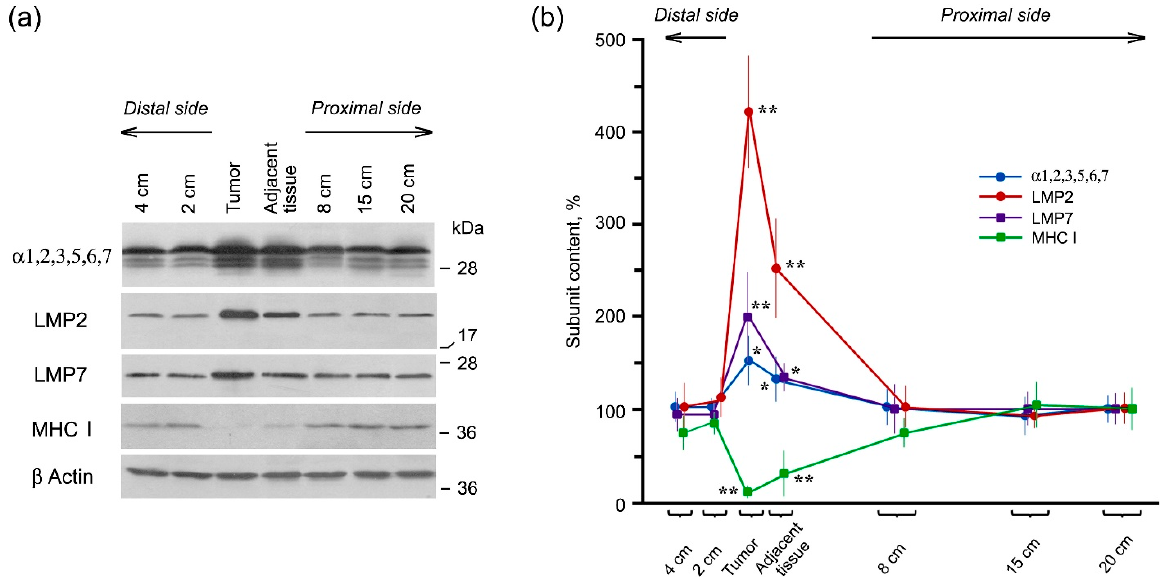
Figure 2. Content of proteasome subunits and MHC class I molecules in rectal adenocarcinoma and different intestine parts of patients. ( a ) Western blots of polypeptides in cleared homogenates with the use of the corresponding antibodies. Molecular mass of standard protein markers is shown. ( b ) The relative polypeptide content normalized to β actin level in percentage from the content in the most distant tissue sample (20 cm from the tumor). Standard deviation is shown as whiskers. The content of all polypeptides in the tumor and adjacent tissue differs reliably from that in other intestine locations at p < 0.05 (*) and p < 0.001 (**).